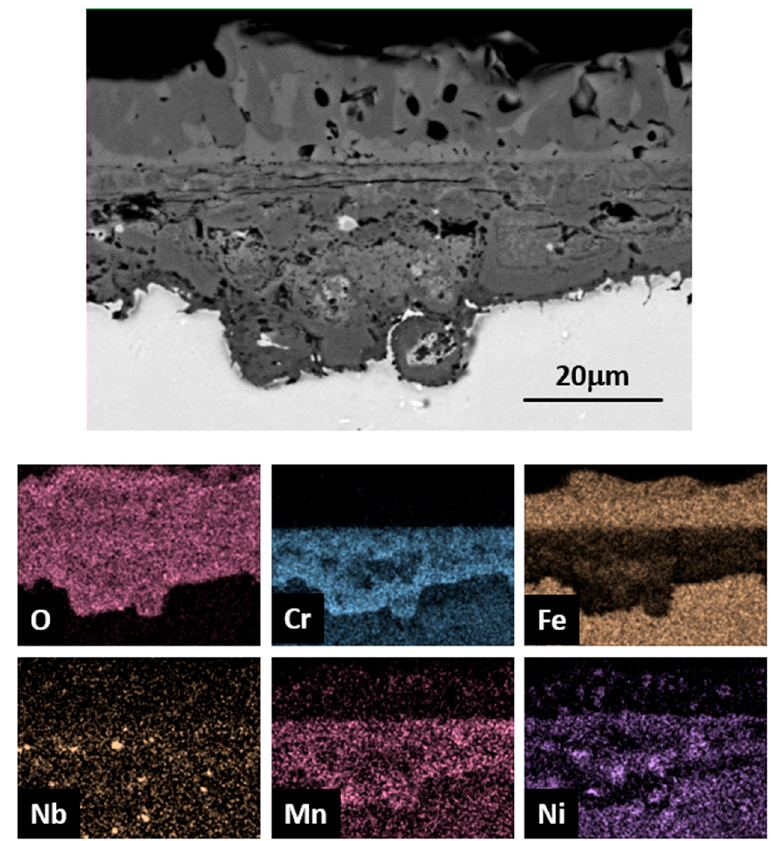
Figure 12. FESEM cross section and EDS element maps of HT347HFG exposed to steam at 700 °C 25 MPa after 3000 h.